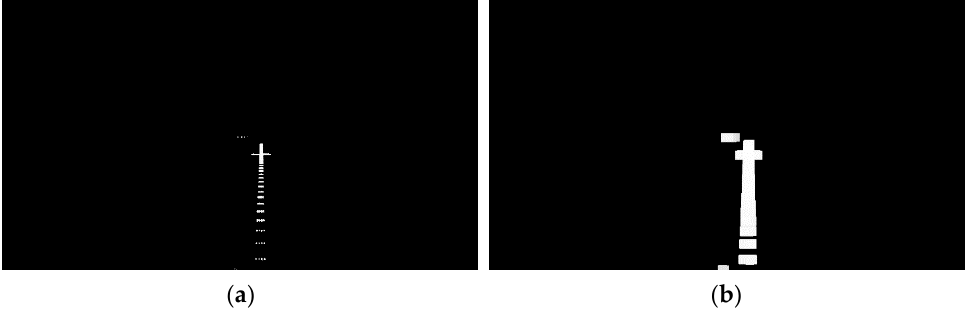
Figure 6. Transformation of the binary picture: ( a ) the binary picture; ( b ) the binary picture after treatment with dilatation transformation.